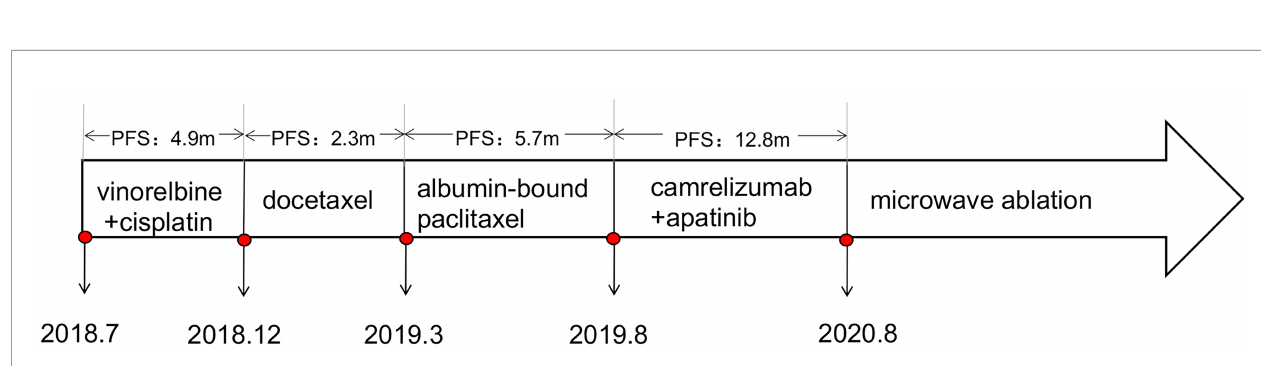
FIGURE 2 | Chest CT scans. (A) CT before immunotherapy. (B) CT revealed a partial response after four months of immunotherapy. (C) CT revealed disease progression after acquired resistance of immunotherapy. (D) CT revealed an abscopal effect after one month of local